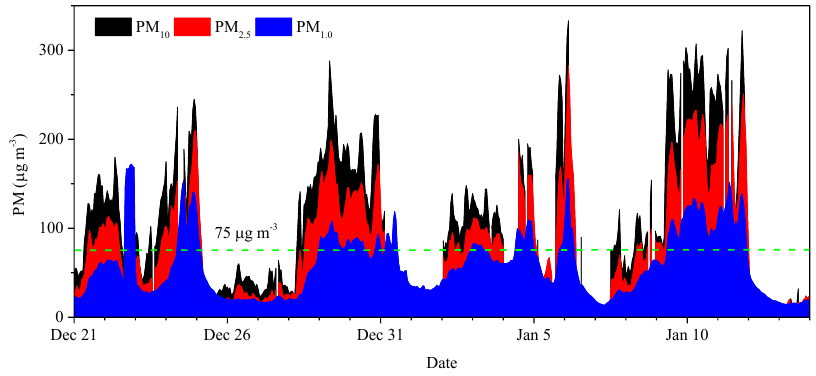
Figure 2. Temporal evolutions of PM 1 . 0 , PM 2 . 5 , and PM 10 concentrations during the winter observation.